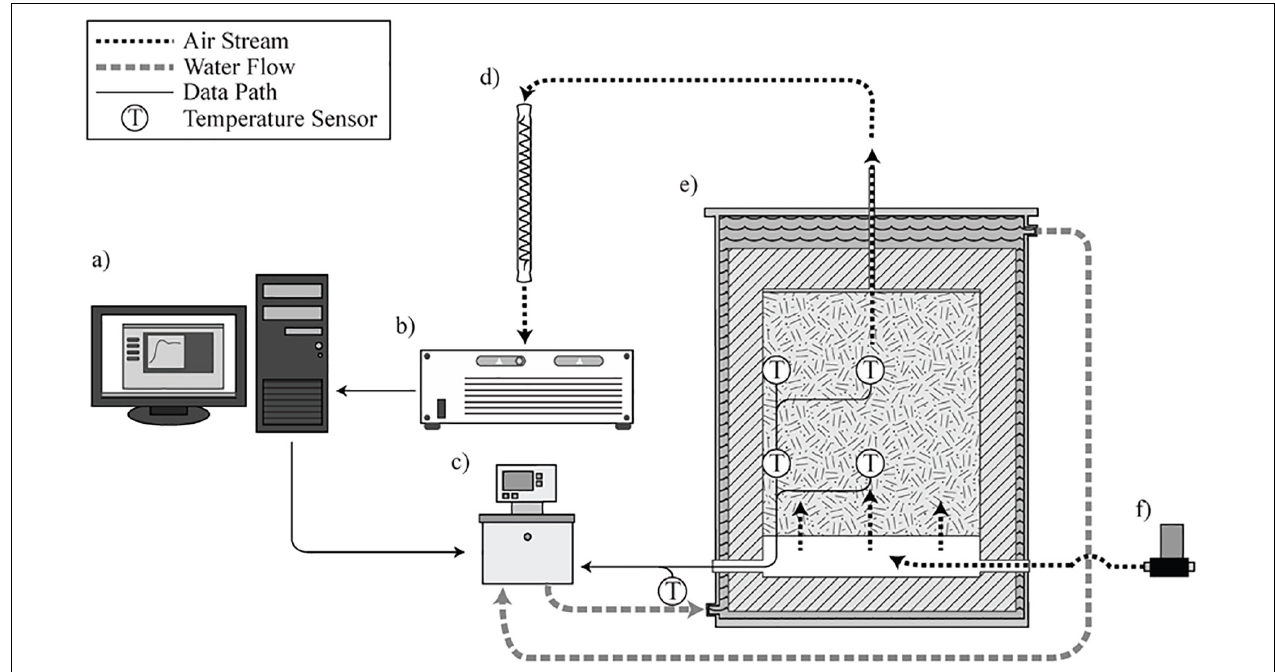
FIGURE 2 | Operational illustration of the laboratory reactor system. (a) LabView control interface and data logging. (b) Gas chromatograph. (c) Heated water circulator. (d) Vapor condenser. (e) Reactor loaded with biomass in operation. (f) Mass flow controlled gas supply (Wendt et al., 2014; Bonner et al., 2015).